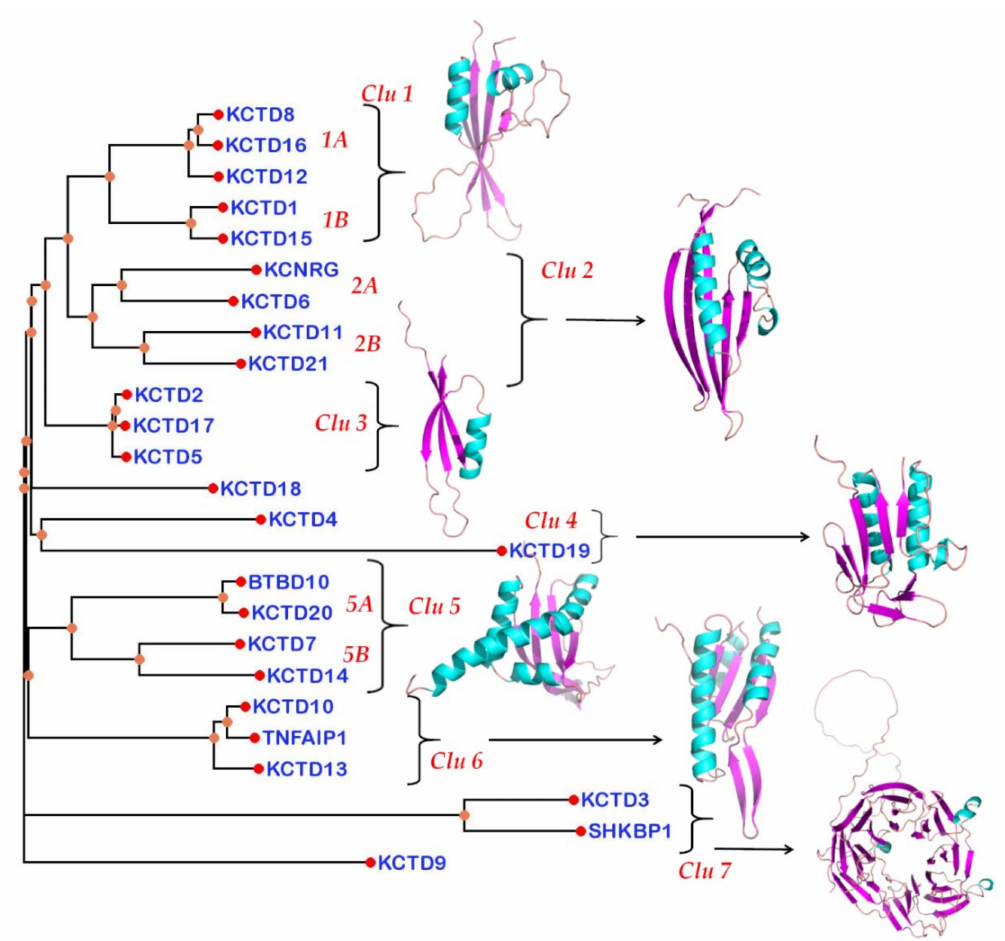
Figure 3. Dali dendrogram generated using the structure of the KCTD-CTD domain. Representative three-dimensional models of the folded domains present in the C-terminal region are also shown. Helices and β -sheets are shown in cyan and magenta, respectively. The cluster numbering is reported in